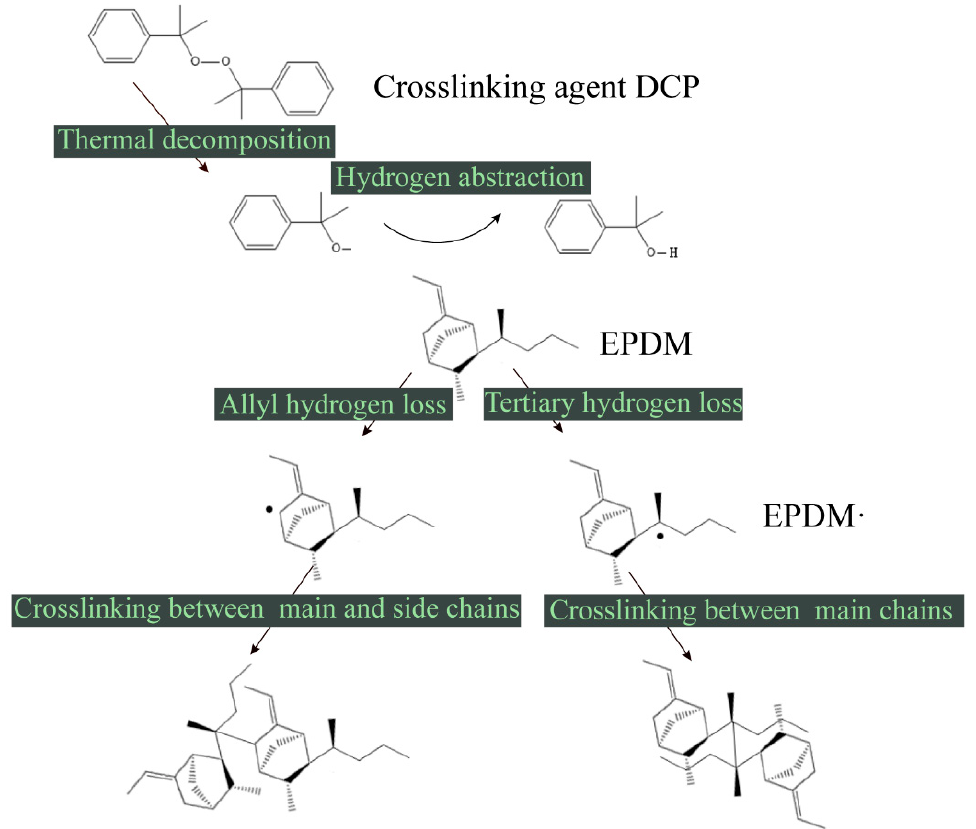
Figure 2. Theoretical cross-linking process of EPDM by dicumyl peroxide (DCP).